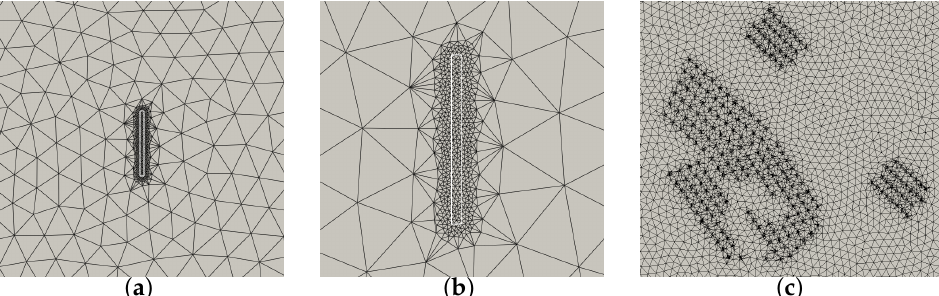
Figure 7. ( a ) Overview and ( b ) closeup of the adapted disc mesh for the case of a single turbine, and ( c ) adapted disc mesh for four wind farms on the North